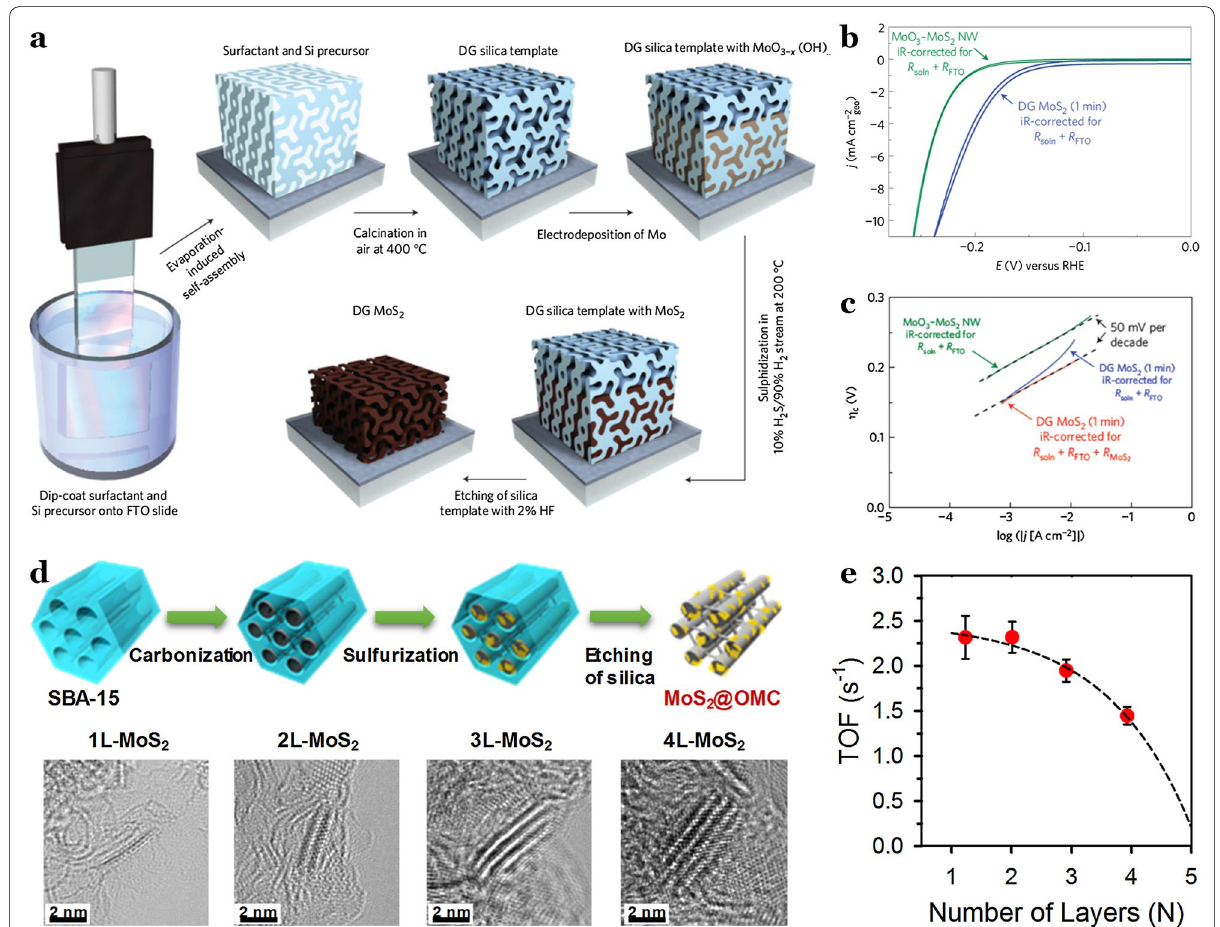
Fig. 6 a Synthetic procedure and structural model for the mesoporous MoS 2 with a double-gyroid (DG) morphology. b Cyclic voltammogram of DG MoS 2 (1 min sample) versus core–shell MoO 3 -MoS 2 nanowires (NW) at 5 mV s − 1 . c Tafel plot of DG MoS 2 (1 min sample) versus core–shell MoO 3 -MoS 2 NW. d Synthetic procedure for the MoS 2 nanosheets embedded on ordered mesoporous carbon nanorods (MoS 2 @OMC), and TEM images for 1L-, 2L-, 3L-, and 4L-MoS 2 @OMC. e TOFs versus the number of layers in the MoS 2 (Figures reprinted with permission from Refs. [22,